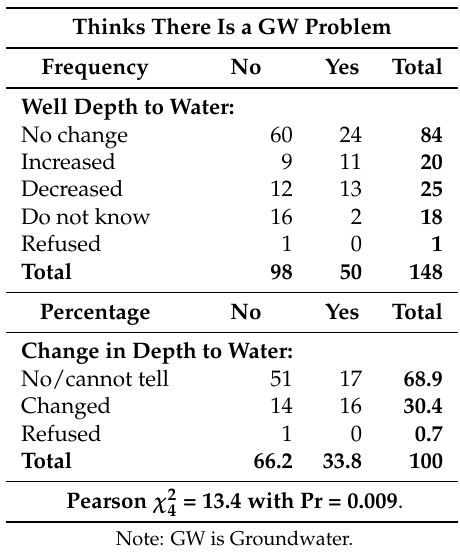
Table 4. Summary statistics of farmer perceptions and attitudes.